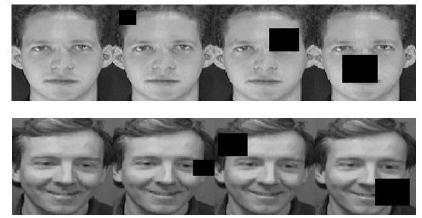
Figure 3. Masking photos from ORL.